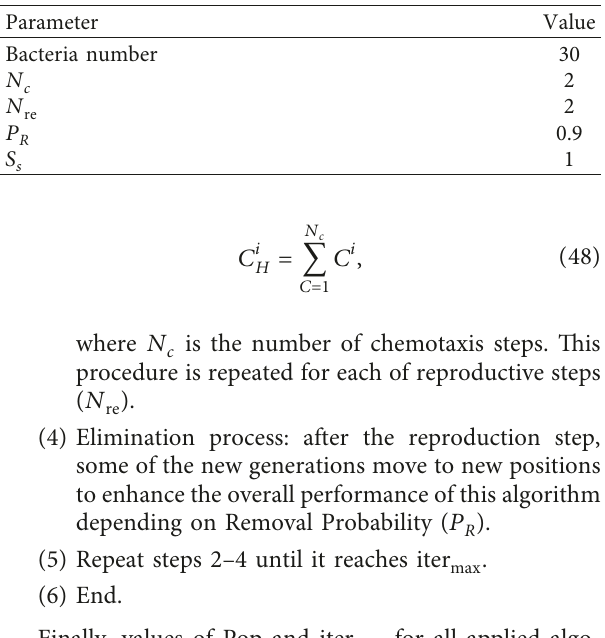
Table 7: Setting of parameters for applied algorithms. Table 6: Initial parameters for the MBFBO